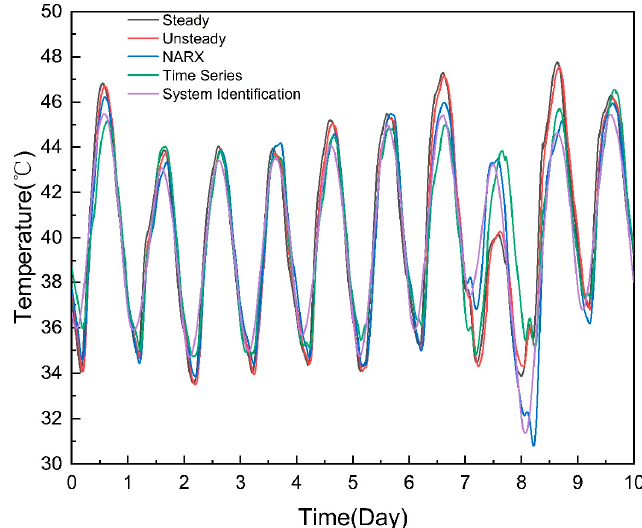
Figure 15. Comparison of thermal simulation results.